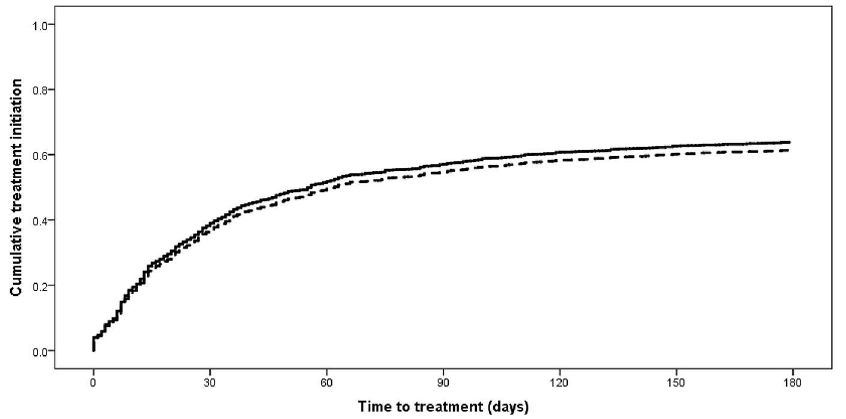
Fig 5. Time to treatment initiation from diagnostic specimen for new rifampicin-resistant tuberculosis patients in the 2013 cohort diagnosed with Xpert compared to other methods ( p < 0.001). Solid line: diagnosed with Xpert; dashed line: diagnosed by other method.